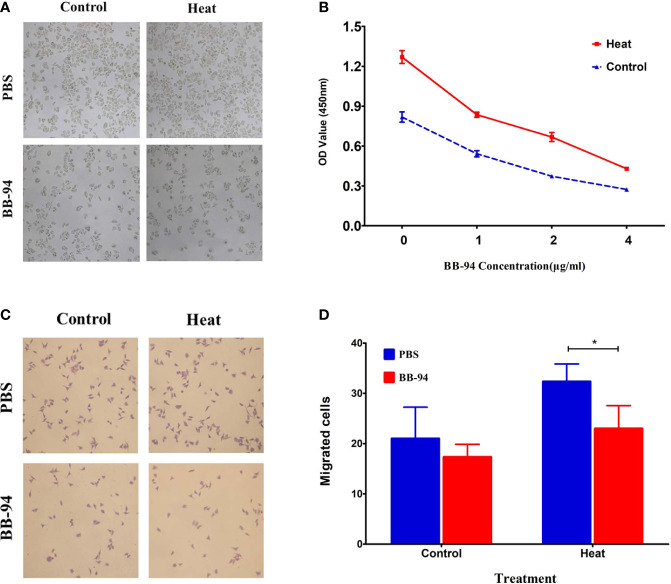

In vitro assessment of cell proliferation and migration after different treatment. (A) CCK 8 assay demonstrated the proliferation ability after heat and BB-94 treatment. (B) Quantitative analysis of the OD value in the different groups at different concentration of BB-94. (C) Transwell assay showed the migration potential of the cells in different groups. (D) Quantitative analysis of the migrated cells after treatment at 37 and 42°C. *P < 0.05.